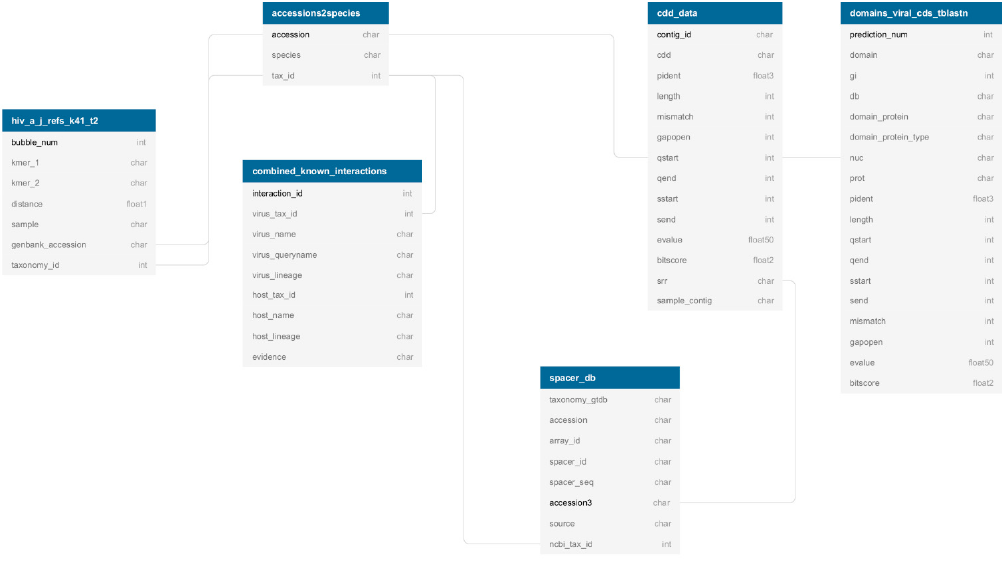
Figure 5. FIVE index schema. Each table (boxes) represents the output from the different annotation